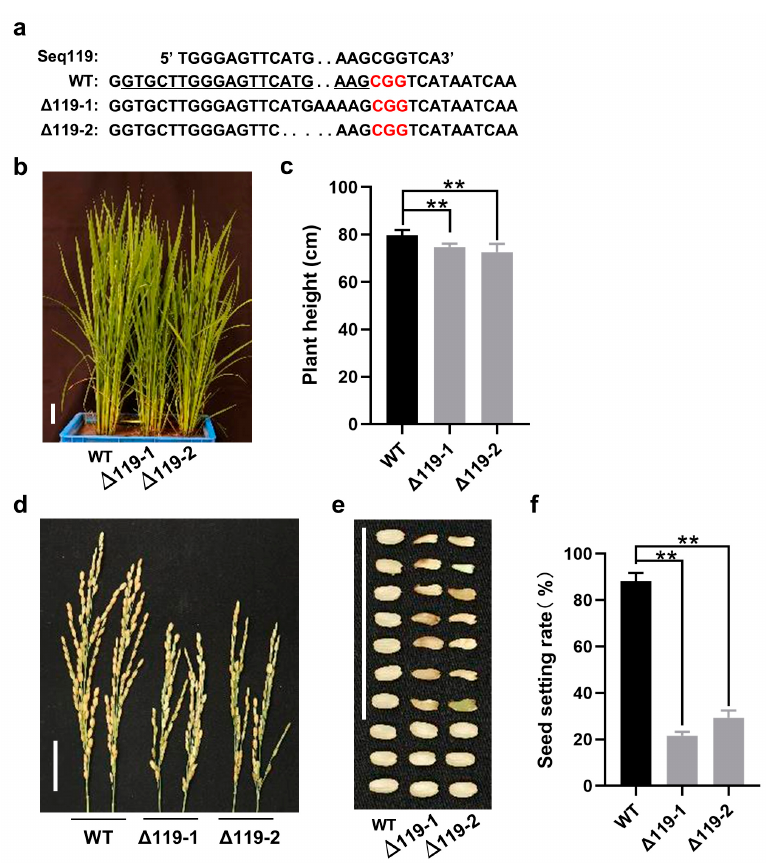
Figure 4. Editing of Seq119 in rice plants: ( a ) Sequence alignment of chromosomal fragment deletion with wild type. (gRNA paired region is labeled with underscored letters, and the PAM region is shown in red letters. The number at the end indicates deleted ( − ) or inserted (+) bases.) ( b ) Two lines of Seq119-edited plants ( Δ 119-1, Δ 119-2). Bars, 4 cm. ( c ) Plant height of Δ 119-1 and Δ 119-2 plants (**